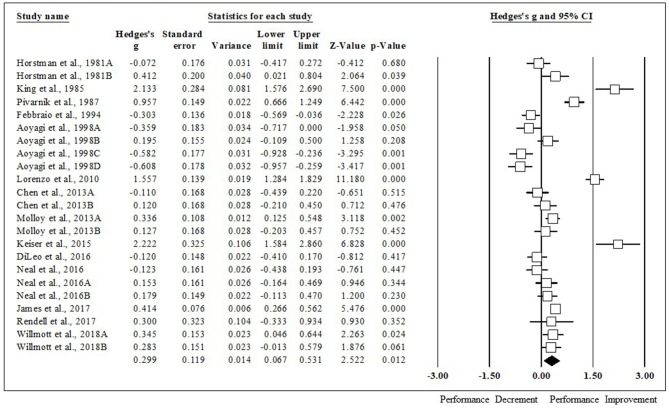
VO2max forest plot. Data are presented as Hedge's g and 95% confidence intervals.